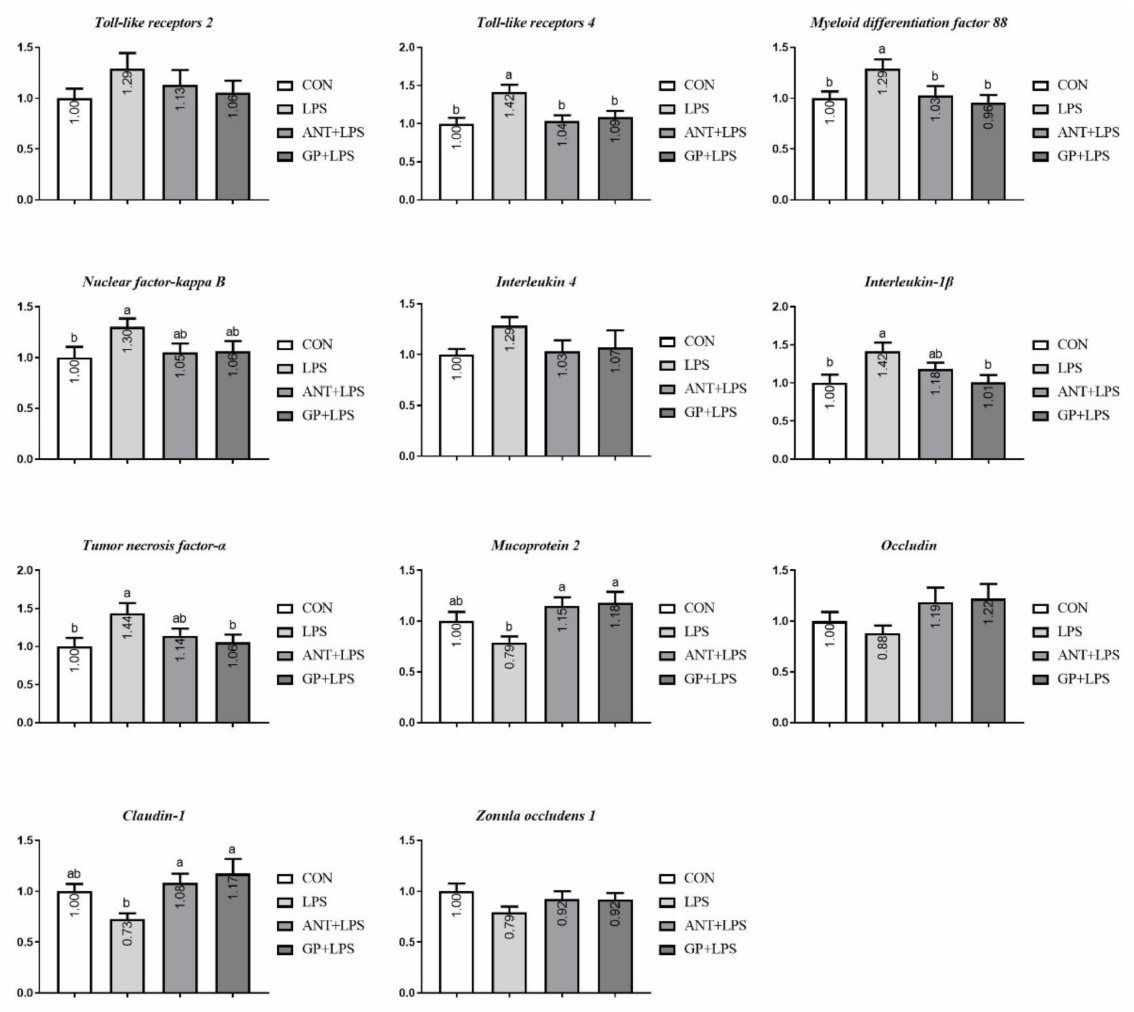
Figure 8. Effects of dietary garlic powder inclusion on relative gene expression of inflammatory cytokines and tight junction in ileum mucosa of broilers challenged with lipopolysaccharide (data were presented as mean and SEM, means that do not share the same superscript are significantly different, p <